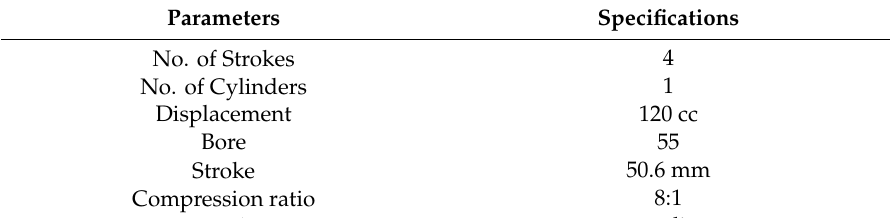
Table 1. The specifications of the crank-rocker engine.